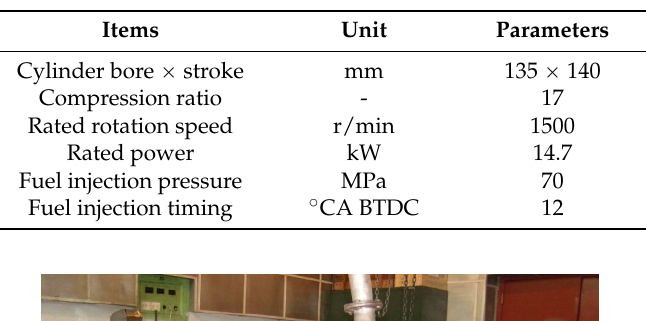
Table 1. Main parameters of the research engine. °CA BTDC means crank angle degrees before top dead center.